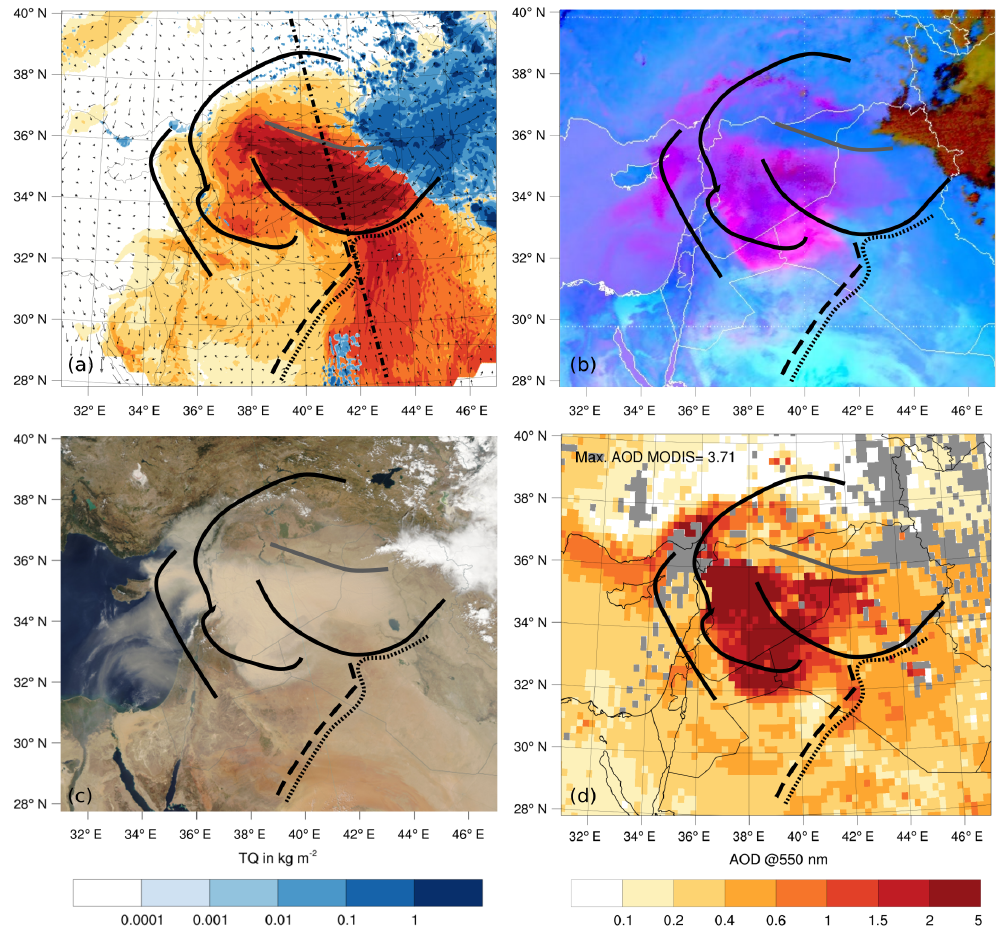
Figure 6. ICON-ART model results and satellite observations for 10:00UTC on 7 September. Displayed are (a) ICON-ART DOD, column- integrated hydrometeor content and wind velocity; (b) SEVIRI RGB dust product (Kerkmann et al., 2015); (c) Aqua MODIS VIS satellite image, overpass at 10:35UTC (NASA Worldview, 2016); (d) Aqua MODIS AOD retrieval using DB2 algorithm (Levy and Hsu, 2015), overpass at 10:35UTC. The dash–dotted black line marks the CALIPSO ground track at